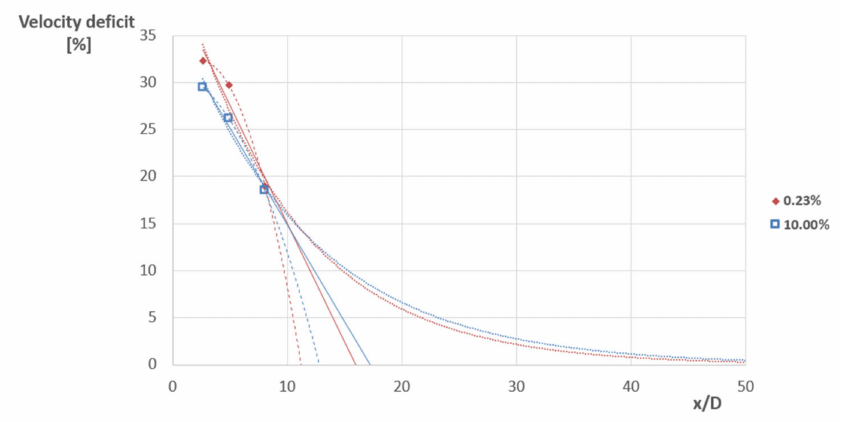
Figure 11. Velocity deficit downstream wind turbines (horizontal profile data): data points and their proposed modeling